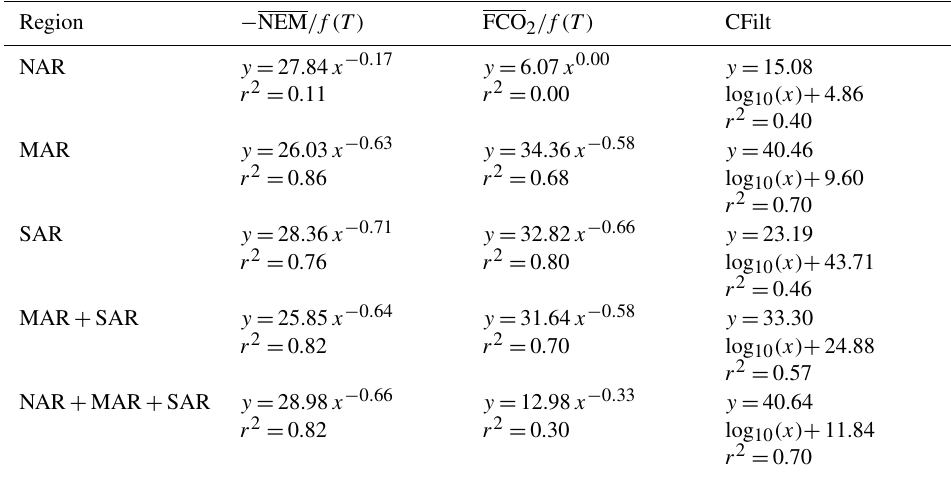
Table 6. Regressions and associated coefficient of determination between the depth-normalized residence time ( S/Q ) and − NEM /f (T ) , FCO 2 /f (T ) , and